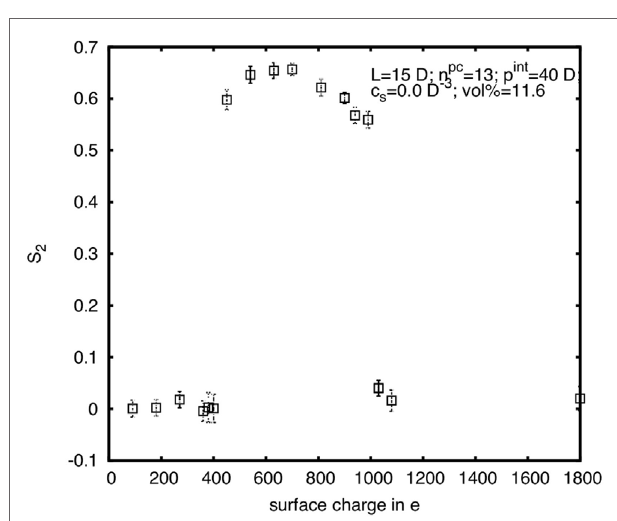
FigUre 11 | nematic order parameter in dependence on the surface charge for rods with diameter D = 5 nm, length L = 15 D , and internal pitch p int = 40 D at a rod volume concentration of φ p = 11.6% .